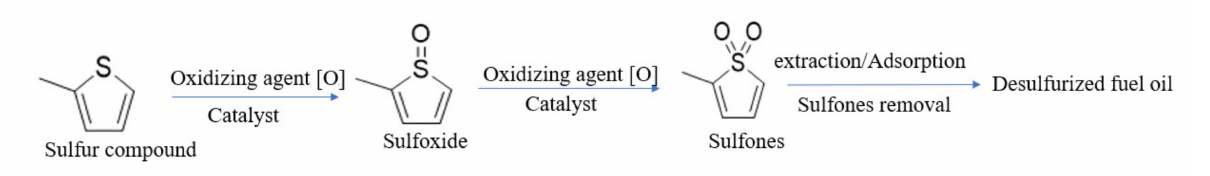
Figure 2. Mechanism involved in the oxidative desulfurization of fuel